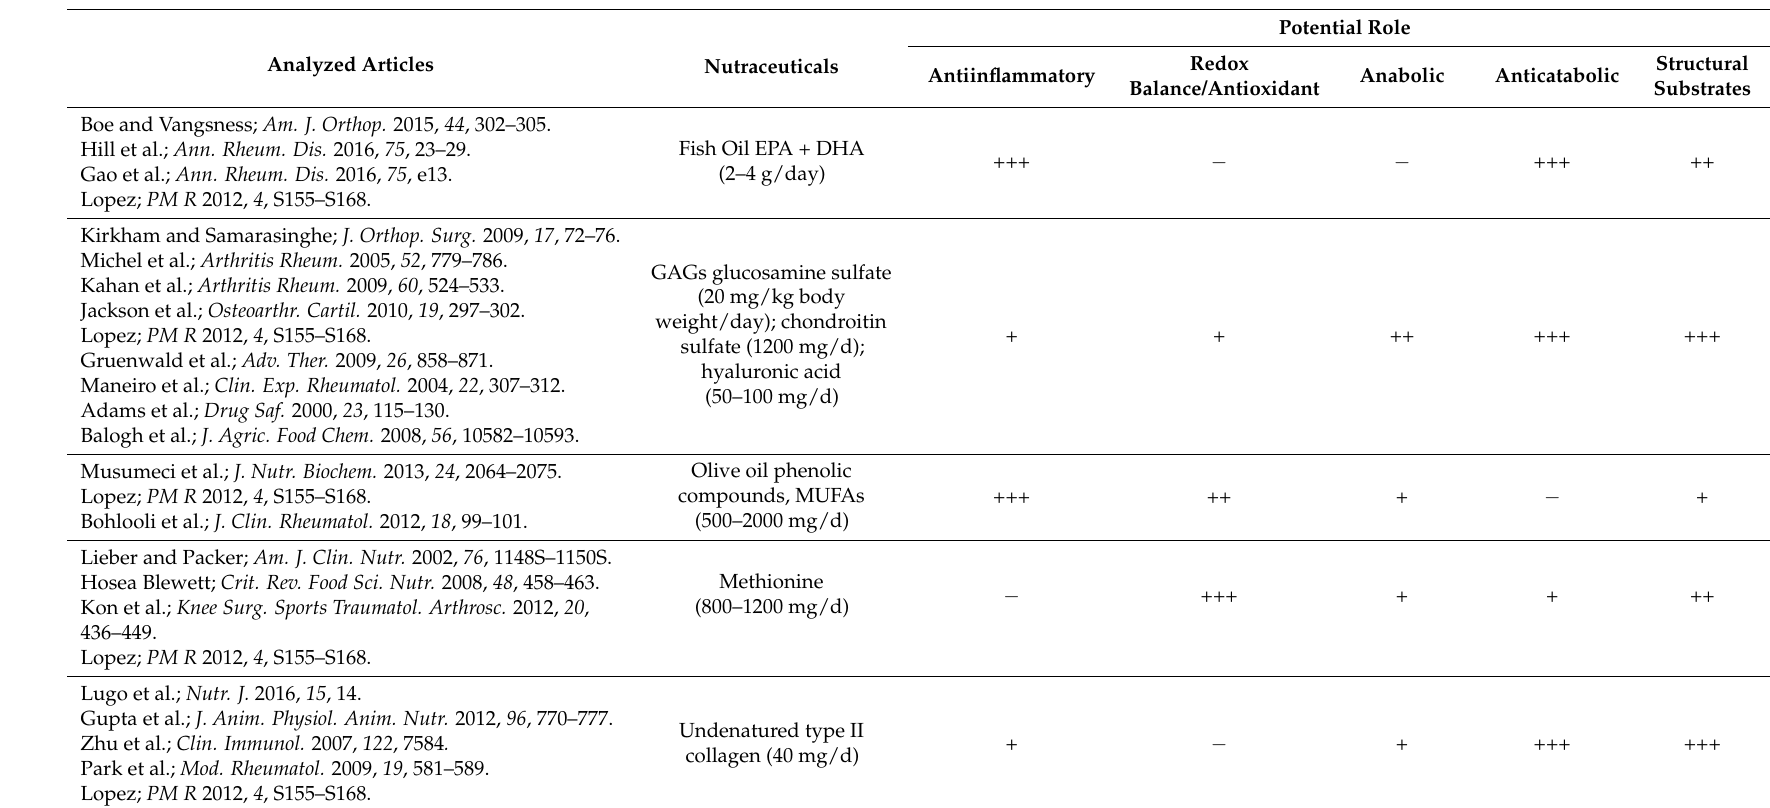
Table 1. Potential role of nutraceuticals in osteoarthritis. Potential role: none “ − “; low “+”; moderate “++”; high